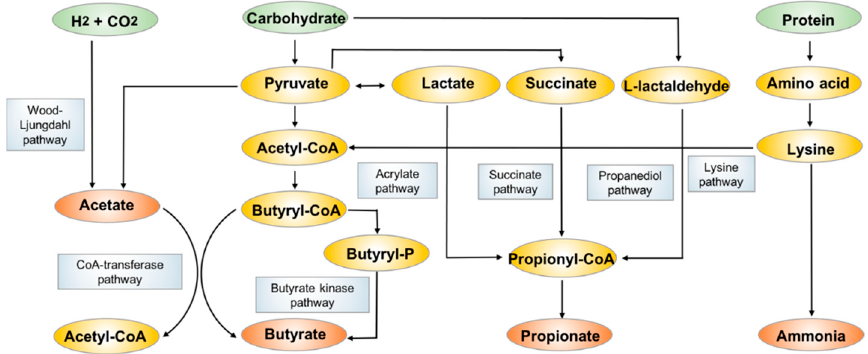
Figure 2. The biosynthesis and metabolism pathways of acetate, propionate and